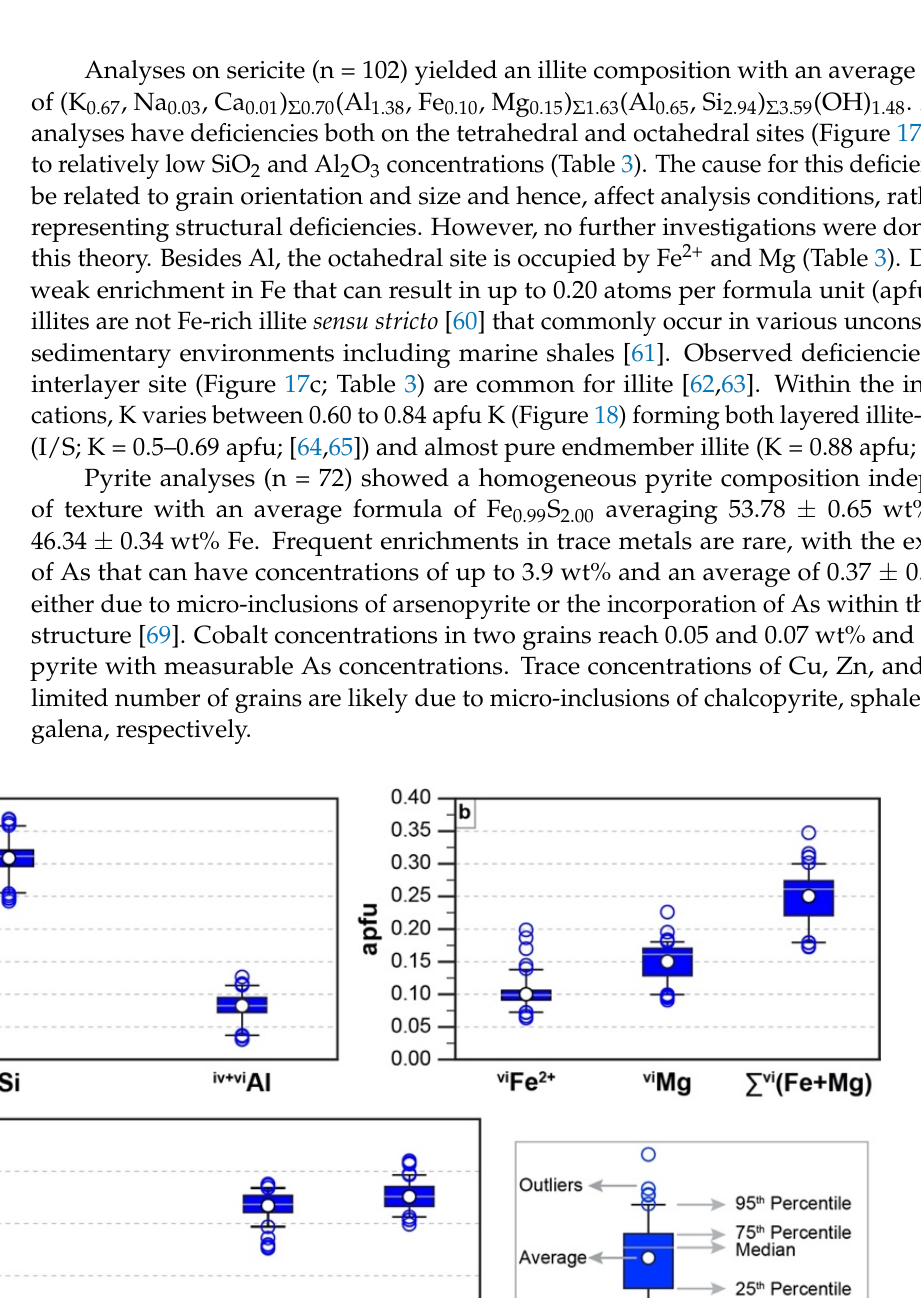
Figure 18. Composition of analyzed illite in 4Si-M+-3R 2 ternary plot after [66,71]. Endmember composition of selected micas and clays are given based on [62,66,67,72]. ( a ) Analyzed illites plot in-between illite composition with interlayer charges of 0.6 (Ill 0.6 ), 0.65 (Ill0 .65 ) and 0.88 (Ill 0.88 ). ( b ) Close up of (a), illite composition vary between I/S composition (ill 0.60– 0.65 ) and endmember illite composition (Ill 0.88 ) which is a function of increasing temperature (orange arrow).